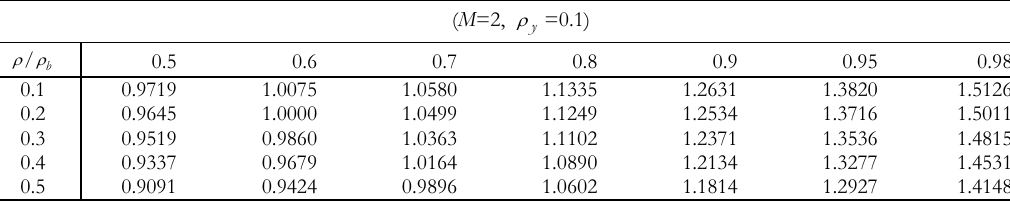
Relative efficiency of cluster sampling over simple random